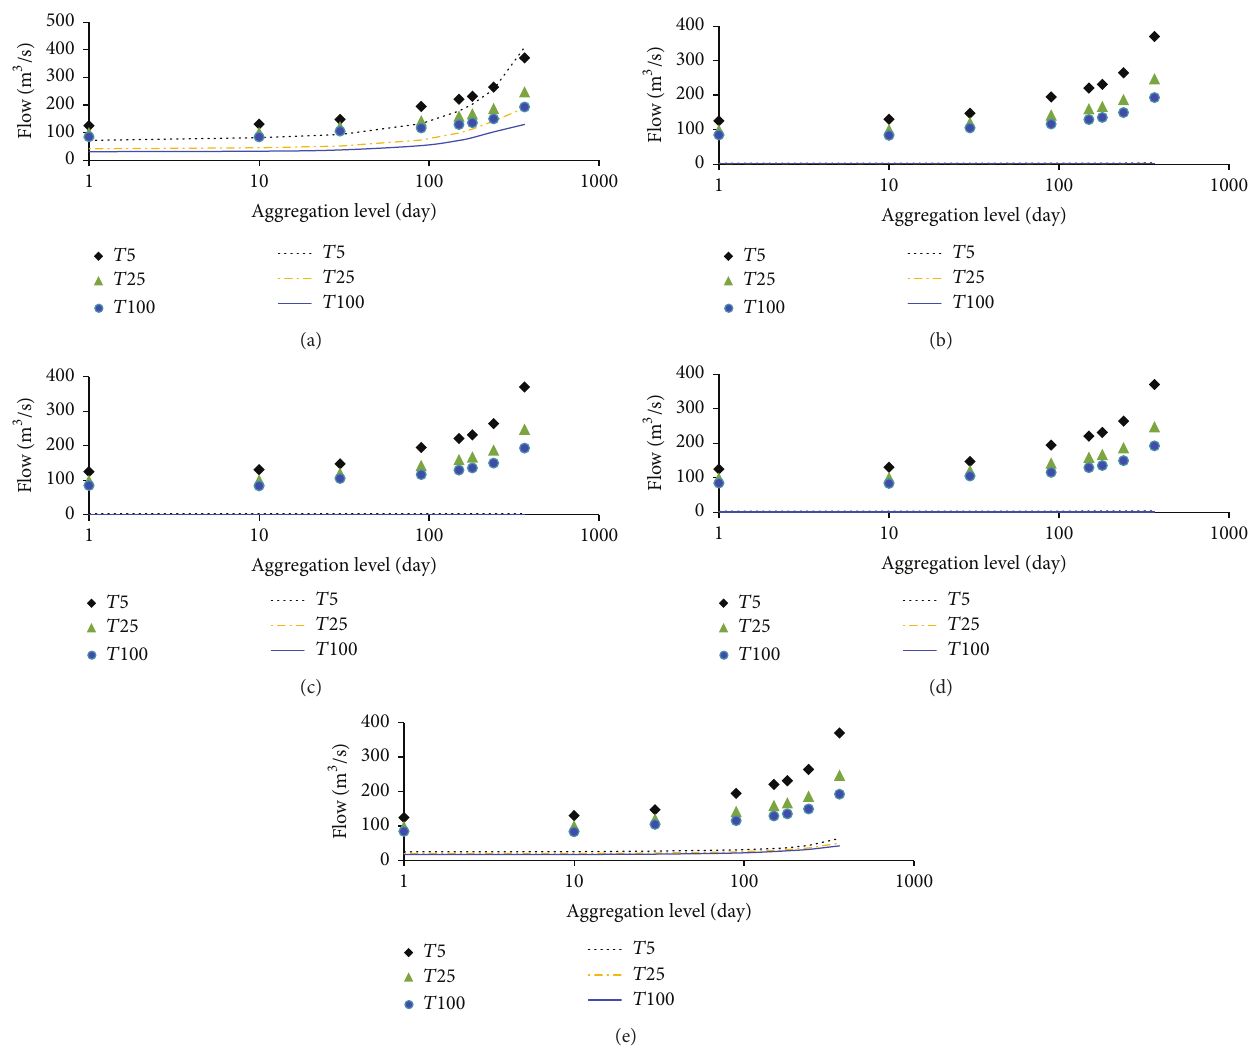
Figure 12: QDF relationships for observed extreme low flows and modeled flows from (a) AWBM, (b) IHACRES, (c) SAC, (d) SIMHYD, and (e) TANK. Markers and lines are for observed and modeled flows, respectively. In the legend, for example, 𝑇25 denotes 𝑇 -year curve for 𝑇 = 25 years.